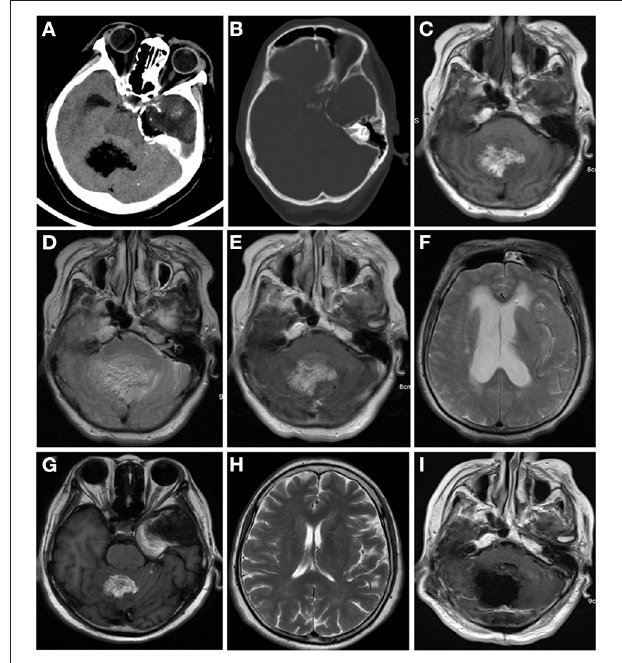
FIGURE 1 | Computed tomography (CT) and contrast-enhanced magnetic resonance imaging (MRI) were performed in June 2018 (A–E) . CT images of brain window images demonstrated a well-demarcated mass with fat density in the left temporal lobe and cerebellar vermis with calcification (A,B) . MRI revealed a hyper- and isointense mixed mass on T1-weighted image (C) and iso- and hyperintense mixed mass on T2-weighted image (D) . Gadolinium-enhanced T1-weighted image showed heterogeneous enhancement (E) . The lesion in the cerebellum compressed the fourth ventricle (E) and caused supratentorial obstructive hydrocephalus (F) . In 2013, the cerebellum lesion was relatively small (G) and did not cause obstructive hydrocephalus (H) . Postoperative MRI indicated the cerebellar mass was near-totally removed (I)